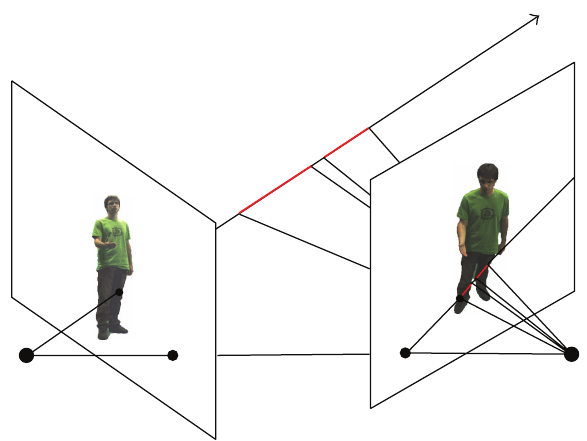
Figure 4: Viewing edges (in bold) along the viewing line.